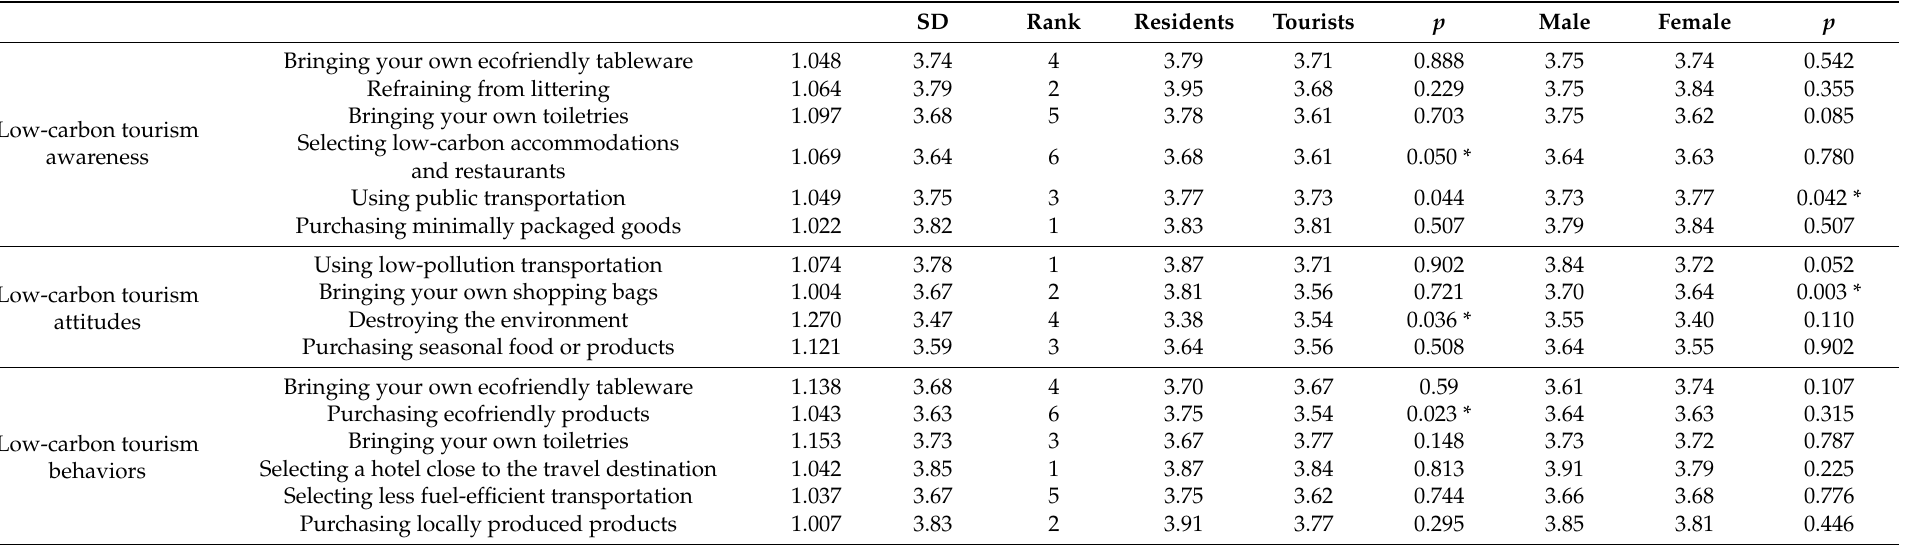
Table 2. Analysis of low-carbon tourism awareness, attitudes, and behaviors. SD Rank p